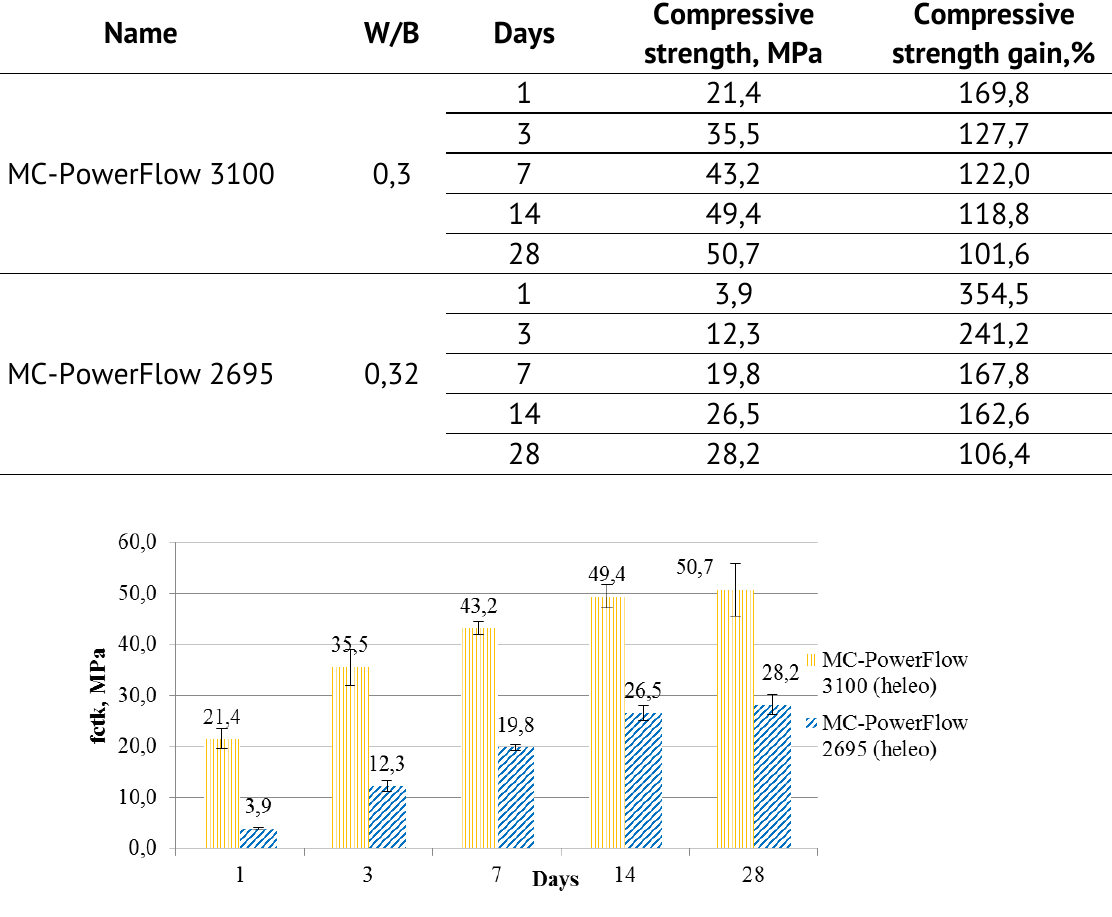
Figure 2. Comparison of the compressive strength of concrete versus its age, using additives of plasticizers, when storing samples in a solar